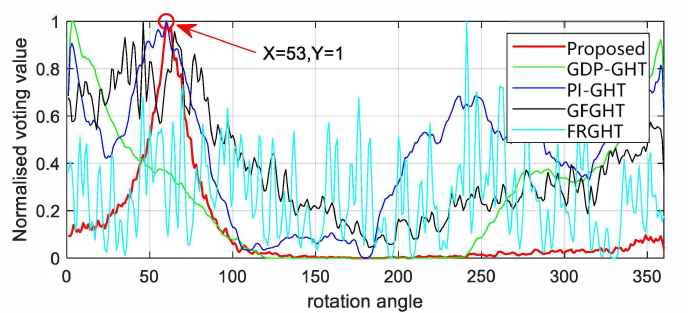
Figure 9. The voting space for rotation for the most-challenging shape S2 with the configuration of rotation = 53 ◦ and scale = 0.73.